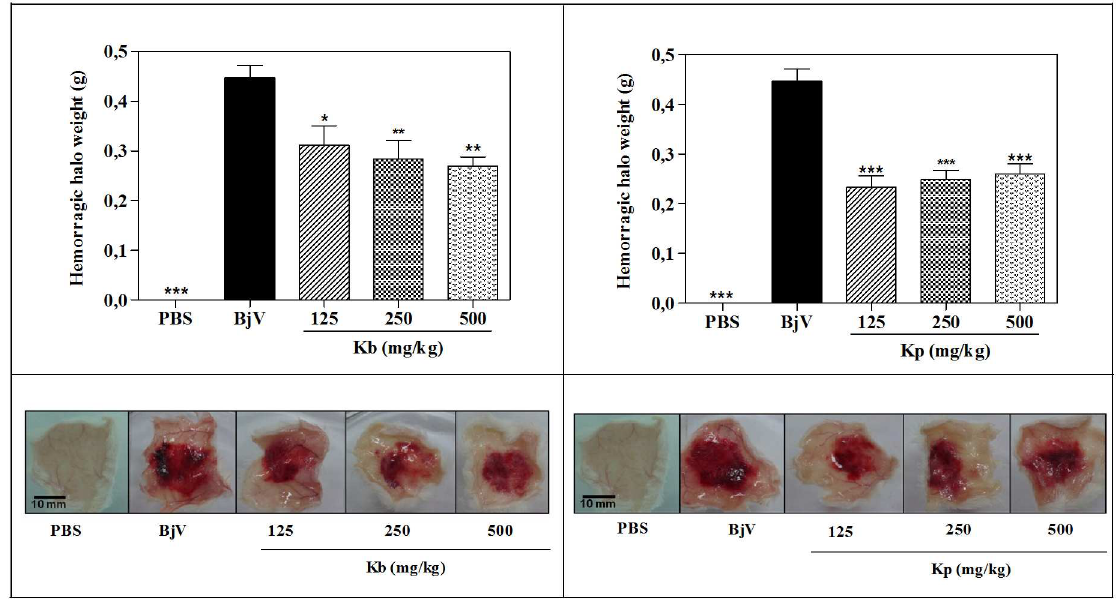
Fig 3. Inhibition of the hemorrhagic activity of B . jararaca (BjV) venom by extractsof K . brasiliensis (Kb) (A) and K . pinnata (Kp) (B) in pre-treatment protocol. BjV was injected s.c. in the ventral regionof mice pre-treatedi.p. with different doses of extracts. Three hours after venom injection, the skin was removedand weighed.The columns represent the mean ± SEM (n = 5). * < 0.05and ** p < 0.01comparedto venom alone (one-way ANOVA followedby the Tukey’s test).